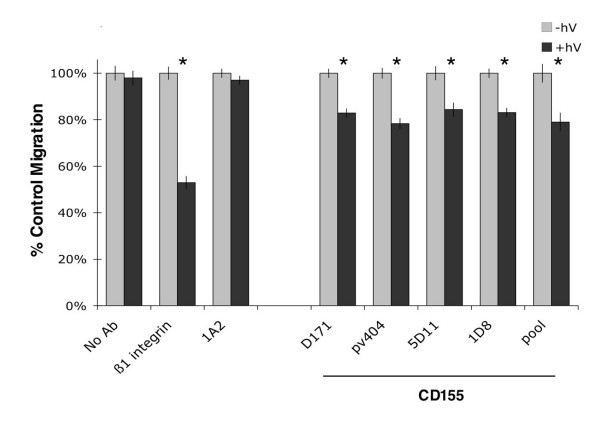
CD155 mediates motility of GBM cells. FALI of CD155 using multiple mAbs resulted in a significant inhibition of U87MG GBM cell transwell migration towards a serum chemoattractant (no Ab 3 ± 3%; β1-int 47 ± 3%; 1A2 (control, surface binding scFv) 3 ± 2%; CD155: D171 17 ± 2%; pv404 22 ± 2%; 5D11 16 ± 3%; IDS 17 ± 2%; CD155pool21 ± 4%; * indicates p < 0.01, t-test). FALI with CD155 mAb pools did not yield greater inhibition, suggesting maximal inactivation or a common binding site.